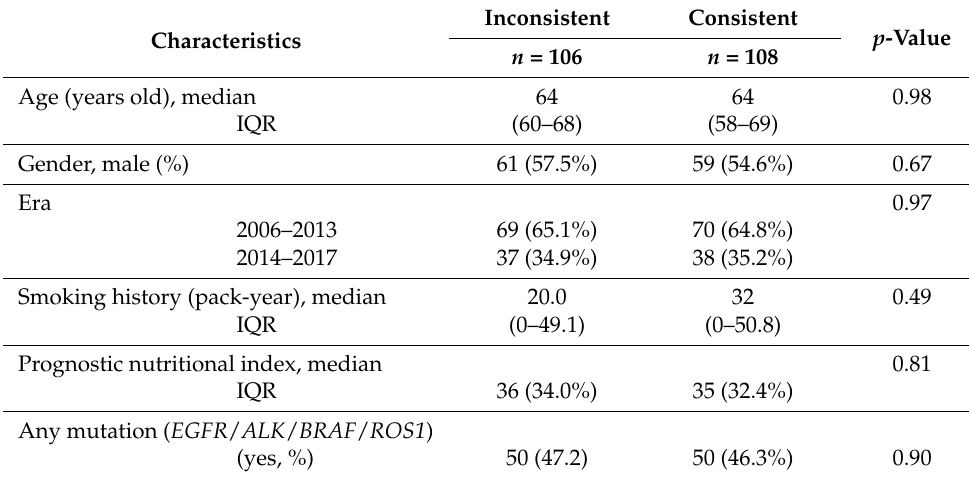
Table 3. Clinicopathological characteristics after propensity